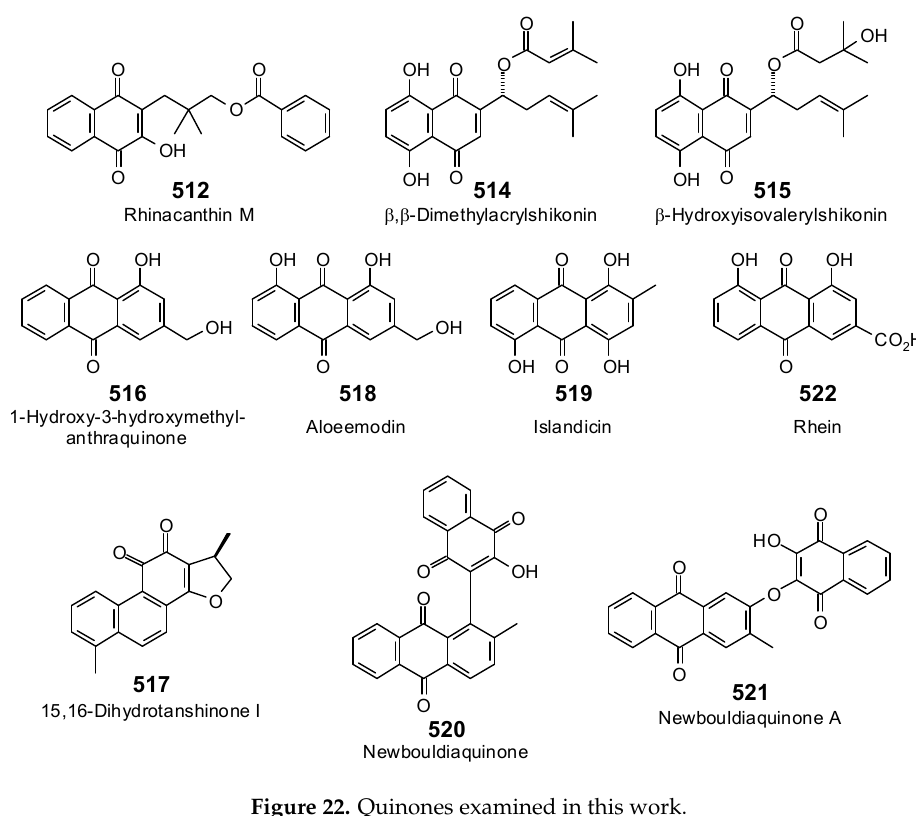
Figure 22. Quinones examined in this work.